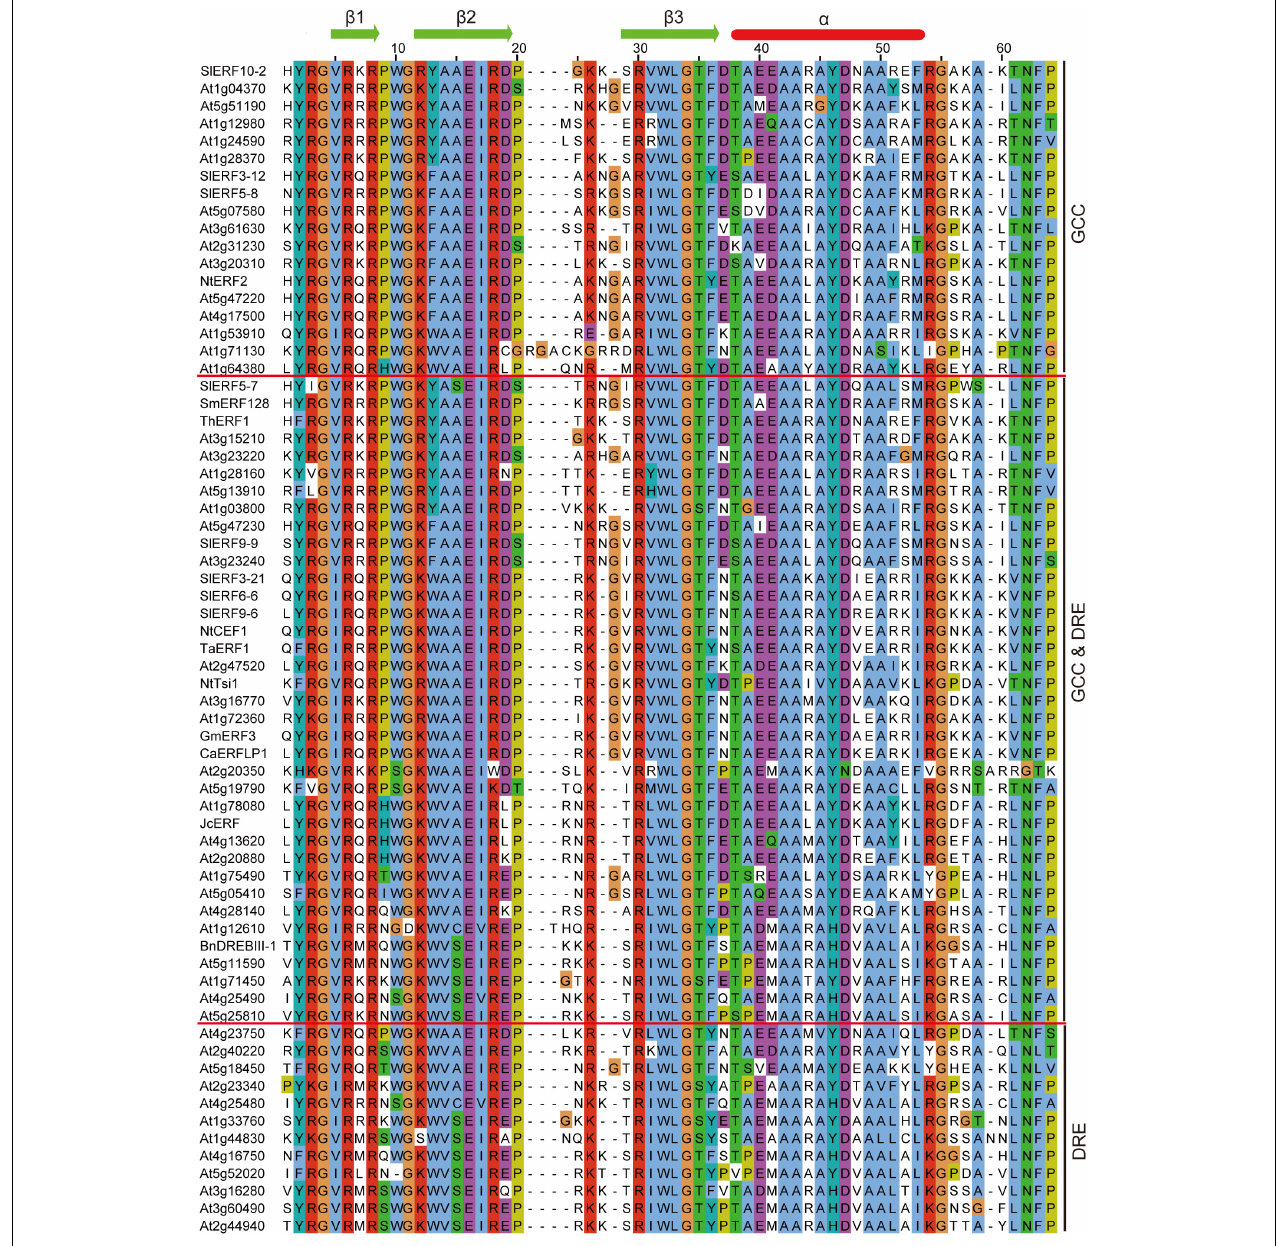
FIGURE 3 | Comparison of the AP2 domain amino acid sequences of 49 A. thaliana and 19 other species ERF proteins. SlERF10-2, SlERF3-12, and SlERF5-8 (Tournier et al., 2003); At1g04370, At5g51190, At1g12980, At1g24590, At1g28370, At5g07580, At3g61630, At2g31230, At3g20310, At4g17500, At1g53910, At1g71130, At1g64380, At3g23220, At1g28160, At5g13910, At1g03800, At2g20350, At5g19790, At4g13620, At2g20880, At1g75490, At4g28140, At1g12610, At1g71450, At4g25490, At2g40220, At5g18450, At2g23340, At4g25480, At1g33760, At1g44830, At4g16750, At5g52020, At3g16280, At3g60490, At4g23750, and At2g44940 (Gong et al., 2008); NtERF2 (Solano et al., 1998); At5g47220, At3g15210, and At5g47230 (Fujimoto et al., 2000); SlERF5-7 (Huang et al., 2004), SmERF128 (Zhang et al., 2019), ThERF1 (Wang et al., 2014), SlERF9-9 (Klay et al., 2018), At3g23240 (Solano et al., 1998), SlERF3-21 (Wu et al., 2008), SlERF6-6 (Zhang et al., 2004), SlERF9-6 (Zhang Z. et al., 2009), NtCEF1 (Lee et al., 2005), TaERF1 (Xu et al., 2007), At2g47520 (Lee et al., 2015), NtTsi1 (Park et al., 2001), At3g16770 (Büttner and Singh, 1997), At1g72360 (Licausi et al., 2010), GmERF3 (Zhang G. et al., 2009), CaERFLP1 (Jae-Hoon et al., 2004), At1g78080 (Lin et al., 2008), JcERF (Tang et al., 2007), At5g05410 (Sakuma et al., 2002), BnDREBIII-1 (Liu et al., 2006), At5g11590 (Wei et al., 2005), and At5g25810 (Sun et al., 2008).